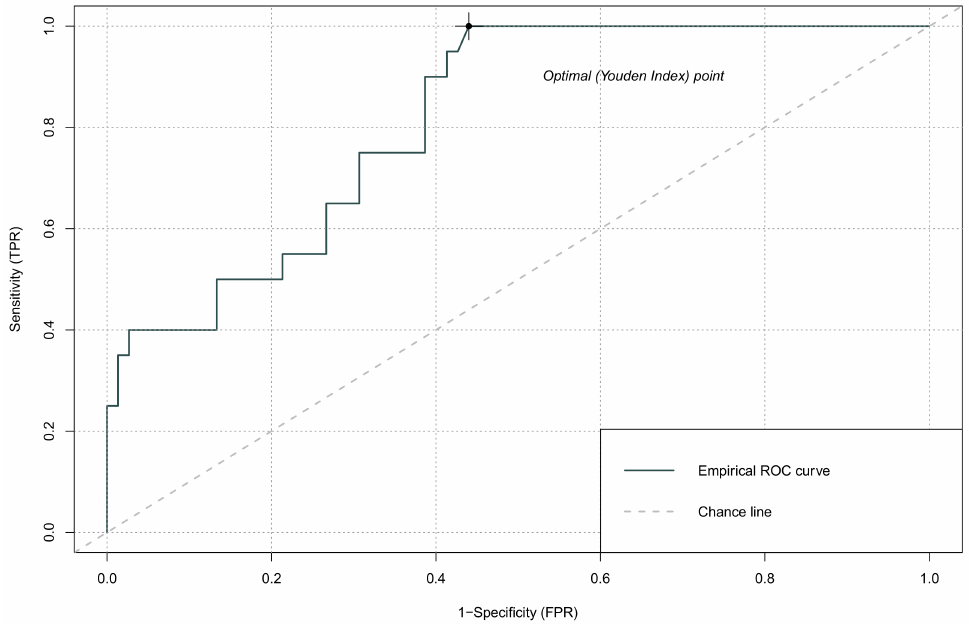
Figure 2. ROC curve analysis for admission GCS score and SII; FPR—false positive rate, TPR—true positive